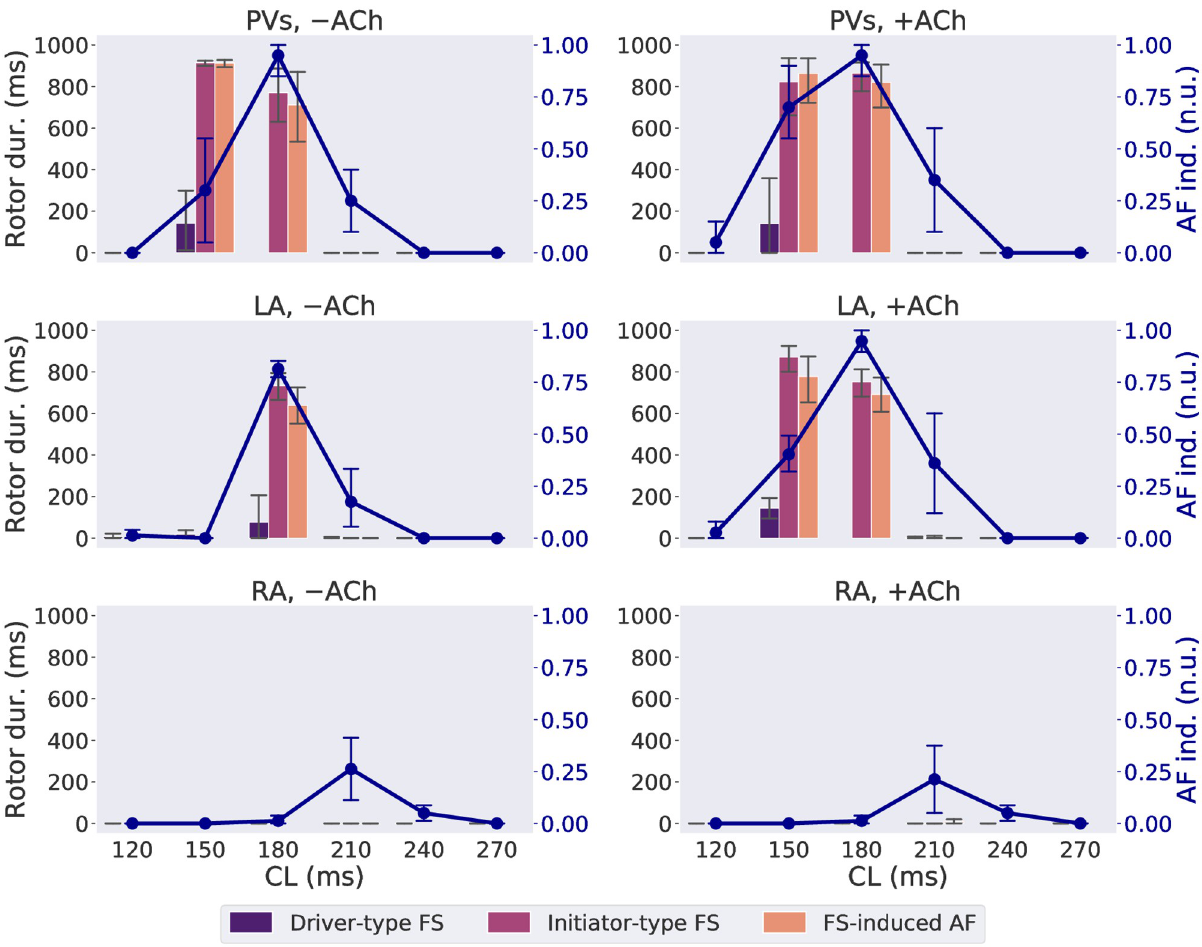
Fig 2. Rotor duration (“Rotor dur.” given by the bars) and AF inducibility (“AF ind.”, given by the line plot) as functions of CL of FS on LA, RA and PVs, with (“+”) or without (“ − ”) ACh. Vertical bars of the line plot show the 95% confidence interval of the mean of all patient meshes. CL groups accounting for less than 5% of FS in each panel were excluded from analysis and the bar charts. n.u.: normalized unit.